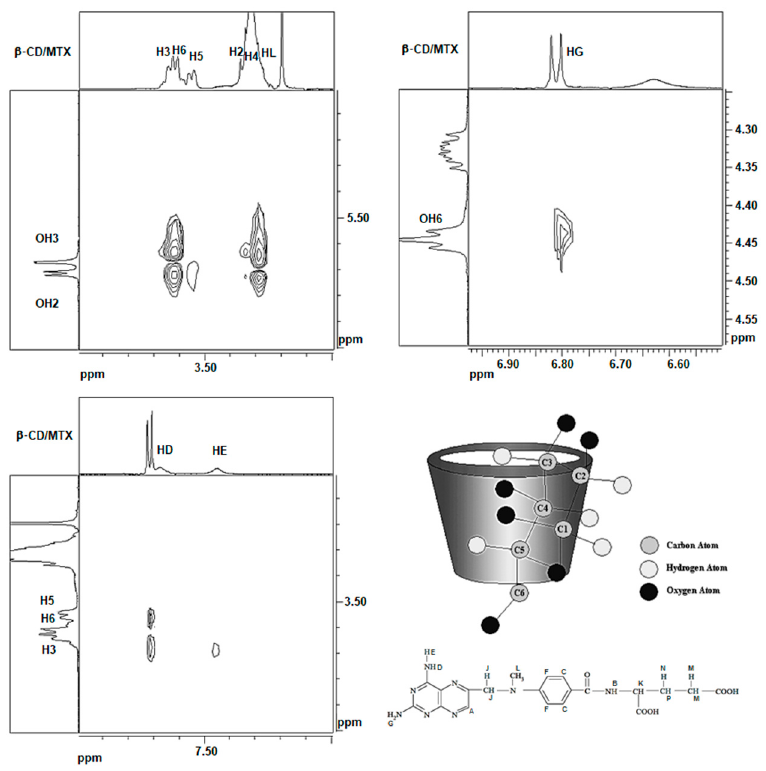
Figure 2. Segmented 2D-ROESY spectrum of β -CD/MTX in DMSO-d 6 solvent and the schematic representation and proton assignment with numbers and letters for β -CD and MTX, respectively.